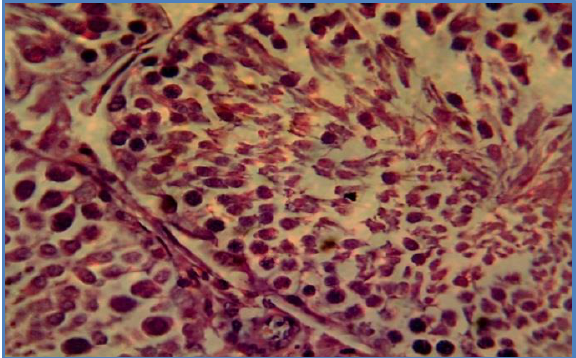
Figure, 3: Cross section of the rat testes control group showing normal structure of seminiferous tubule (H and E stain 40x).